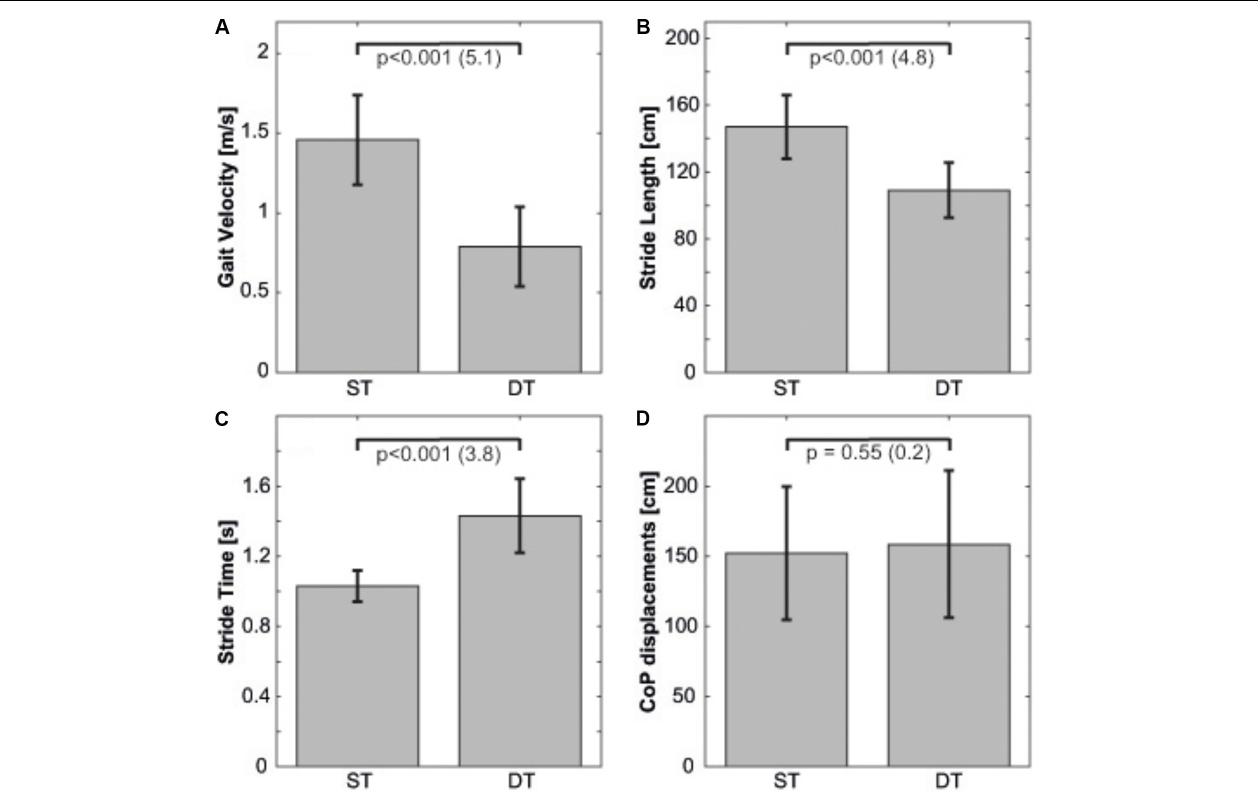
FIGURE 1 | Dynamic and static postural control during single-task and dual-task conditions at baseline, displayed separately for (A) gait velocity, (B) stride length, (C) stride time, and (D) total CoP displacements. Error bars represent the respective standard errors. Values in brackets represent Cohen’s d . CoP, center of pressure; DT, dual-task; ST,